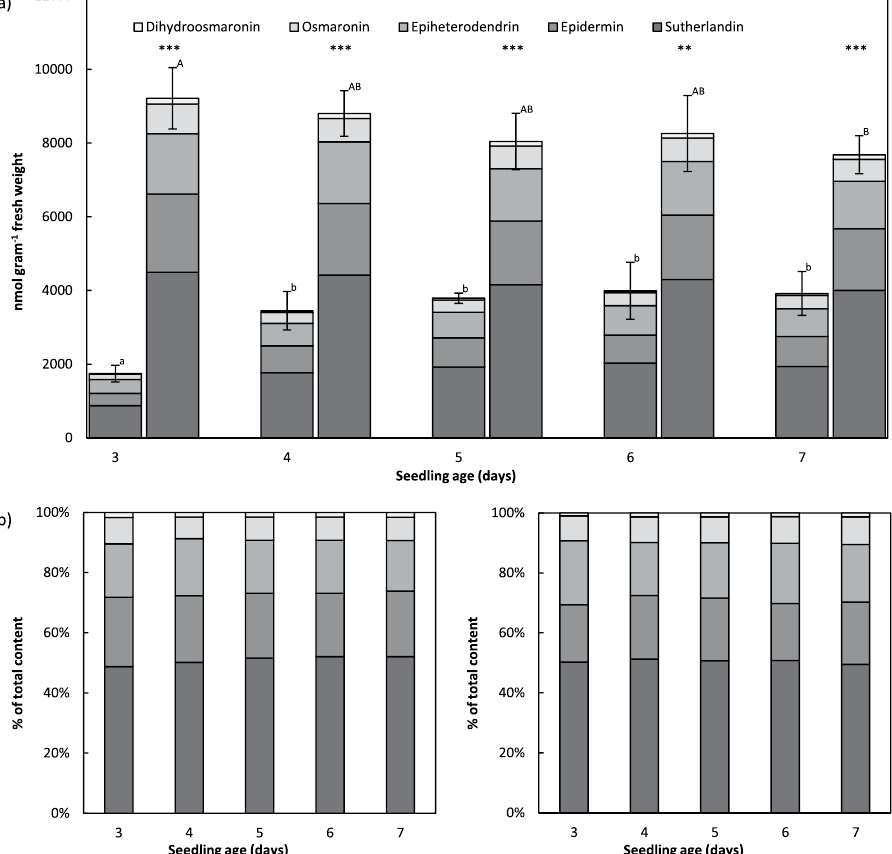
Figure 2. Hydroxynitrile glucoside contents in the cvs. Pallas and Mentor over time and ratios between the compounds. ( a ) Total contents over time in shoot tissue of the cvs. Pallas and Mentor (data shown as means ± s.d.). Asterisks indicate significantly different total contents between the cvs. Pallas and Mentor ( *** p < 0.001, ** p < 0.01). Significantly different groups (p at least < 0.05) within the cultivars are indicated by small letters (Pallas) and capital letters (Mentor). ( b ) Ratio of the individual compounds in percentage of the total content from cv. Pallas (left) and cv. Mentor (right) at each time